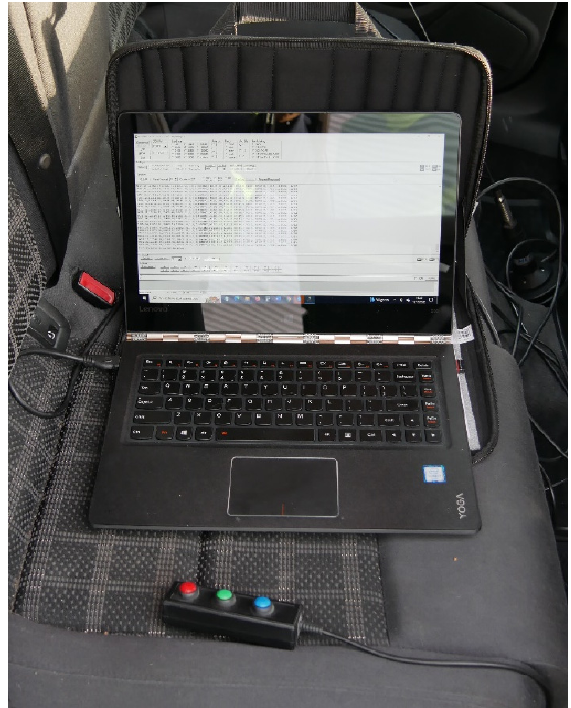
Figure 8. Measurement computer and control panel.